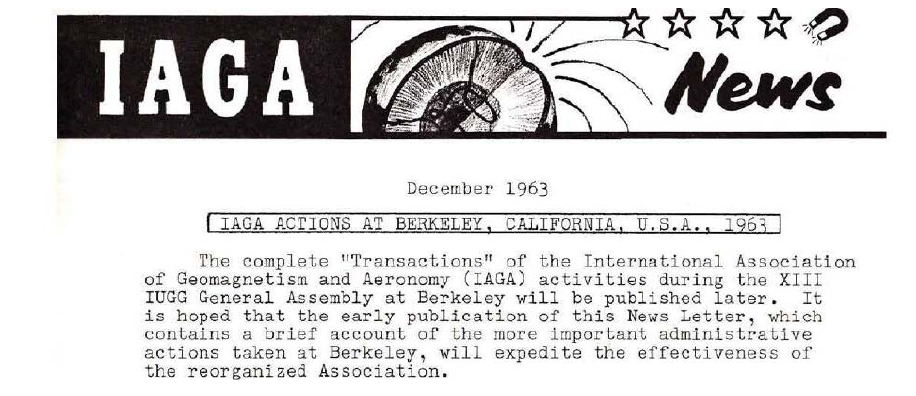
Figure 3. The first issue of the IAGA